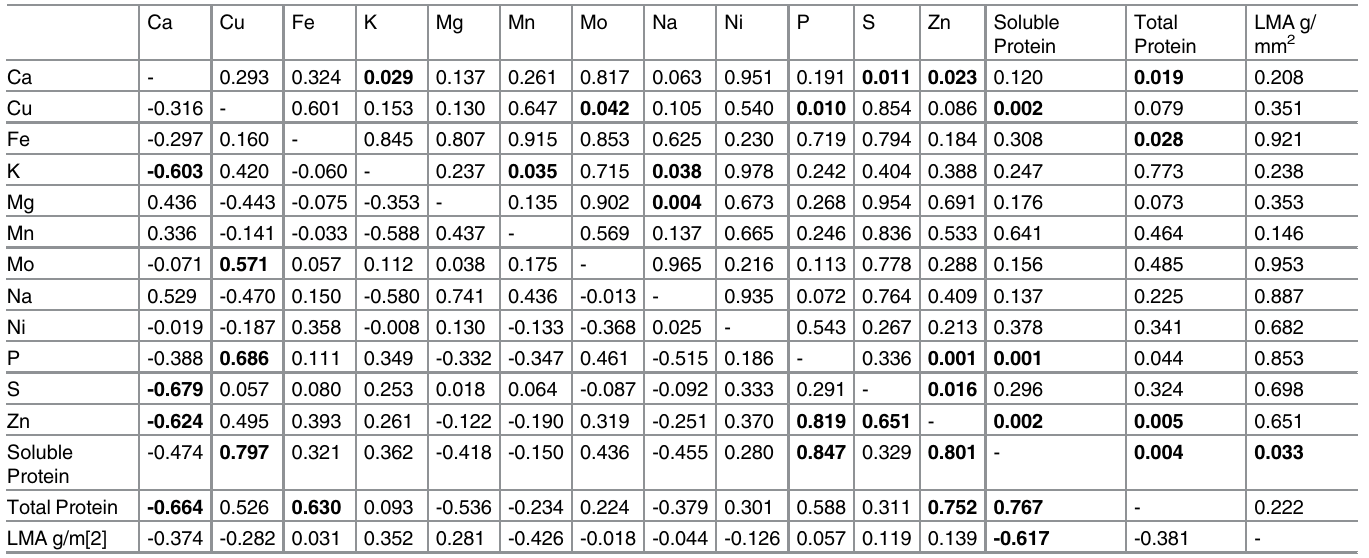
Table 3. Pearson correlation matrix between nutrients plus LMA.